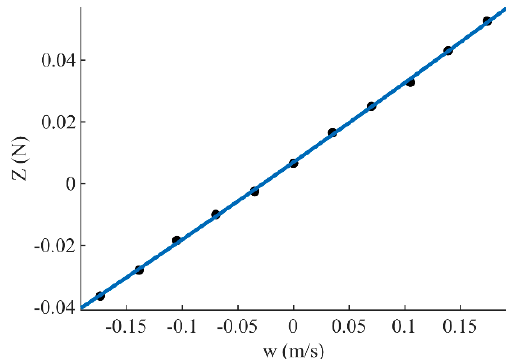
Figure 7. Fitted curve of lateral force Z and linear velocity w.